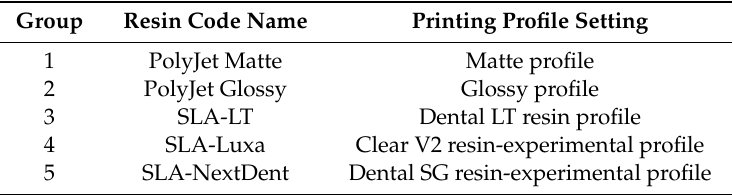
Table 1. Study groups and printing profile